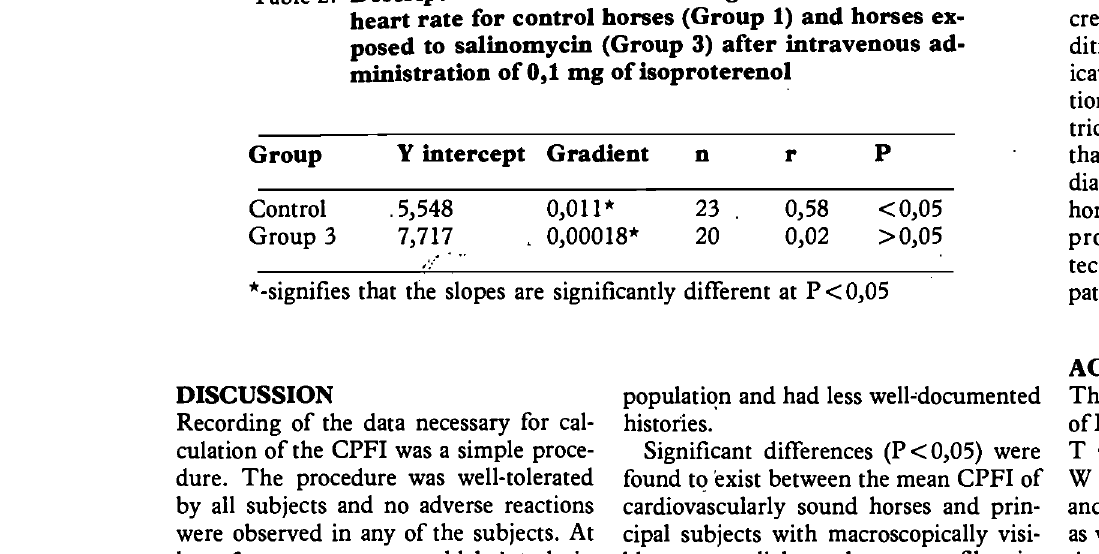
Increase of CPBV without concurrent in. creases in V suggest that toxic myocar. ditis associated with salinomycin intox· ication may result in more severe